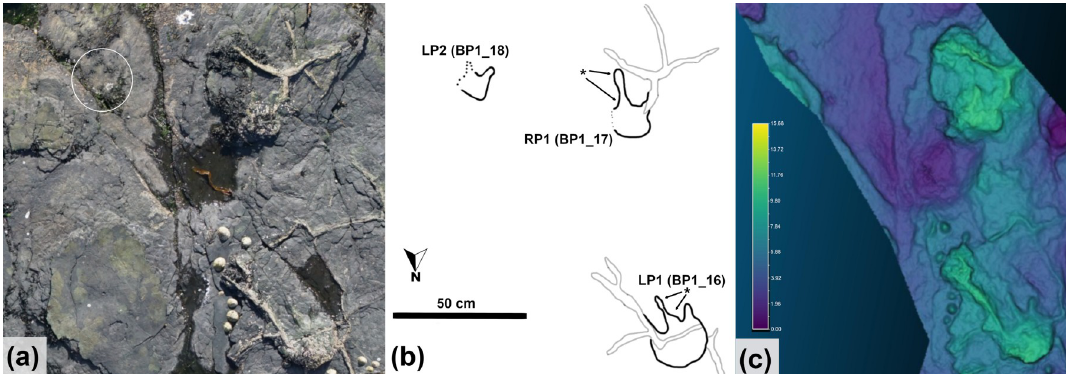
Fig 13. Overview of BP1_Twy_02. (a) The orthophoto of BP1_Twy_02 is shown with (b) a line drawing highlighting distinctive features of both the tracks and the desiccation cracks that preferentially propagate from the toes of the tracks and (c) a false color depth map of the trackway. The line drawing particularly emphasizes the presence of phalangeal pads on digit III of LP1 and RP1 with arrows (labeled � ) pointing out their location within the tracks. The white circle on the (a) shows the location of BP1_18 since it is difficult to discern in both the orthophoto and the depth map. The color scale of (c) is in units of cm.